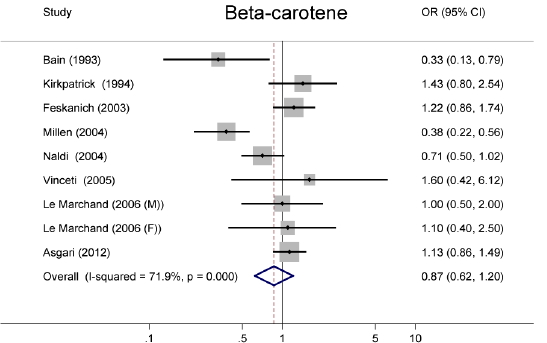
Figure 4. Odds ratios and 95% confidence interval of melanoma for the highest vs. lowest intake of beta-carotene for individual studies and all studies combined.